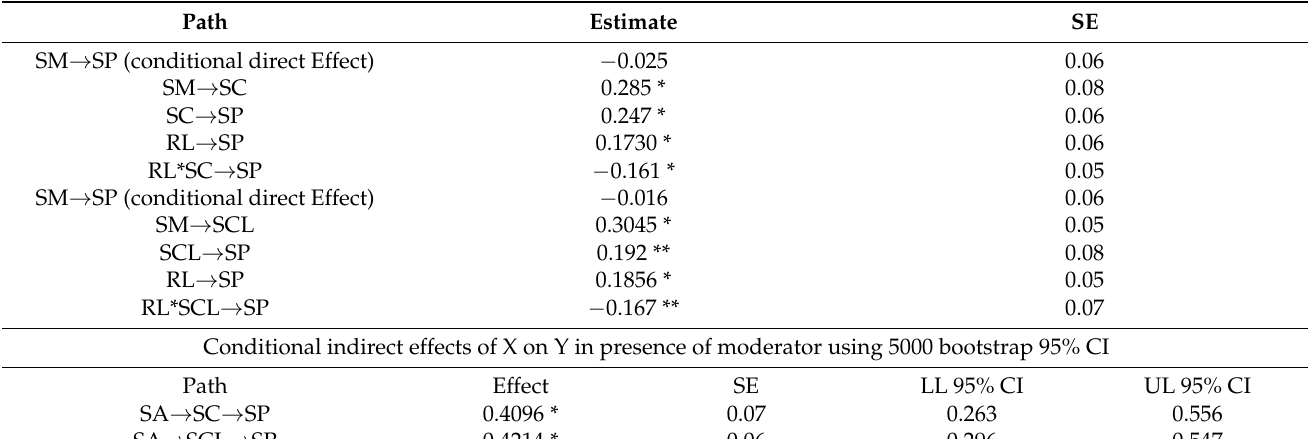
Table 6. Five thousand bootstrap results for PROCESS Model No. 14, mediated moderation analysis.